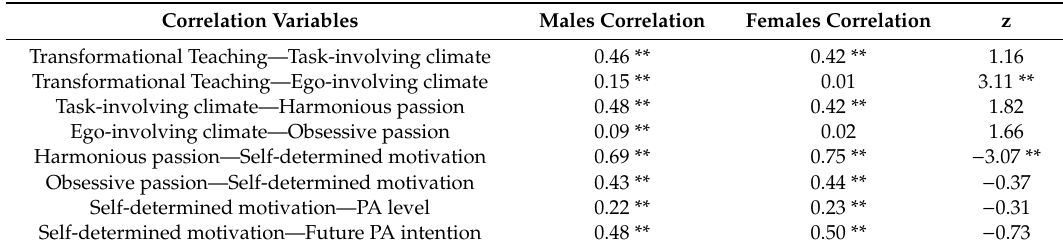
Table 2. Results of values of correlation di ff erences across gender for the study variables.